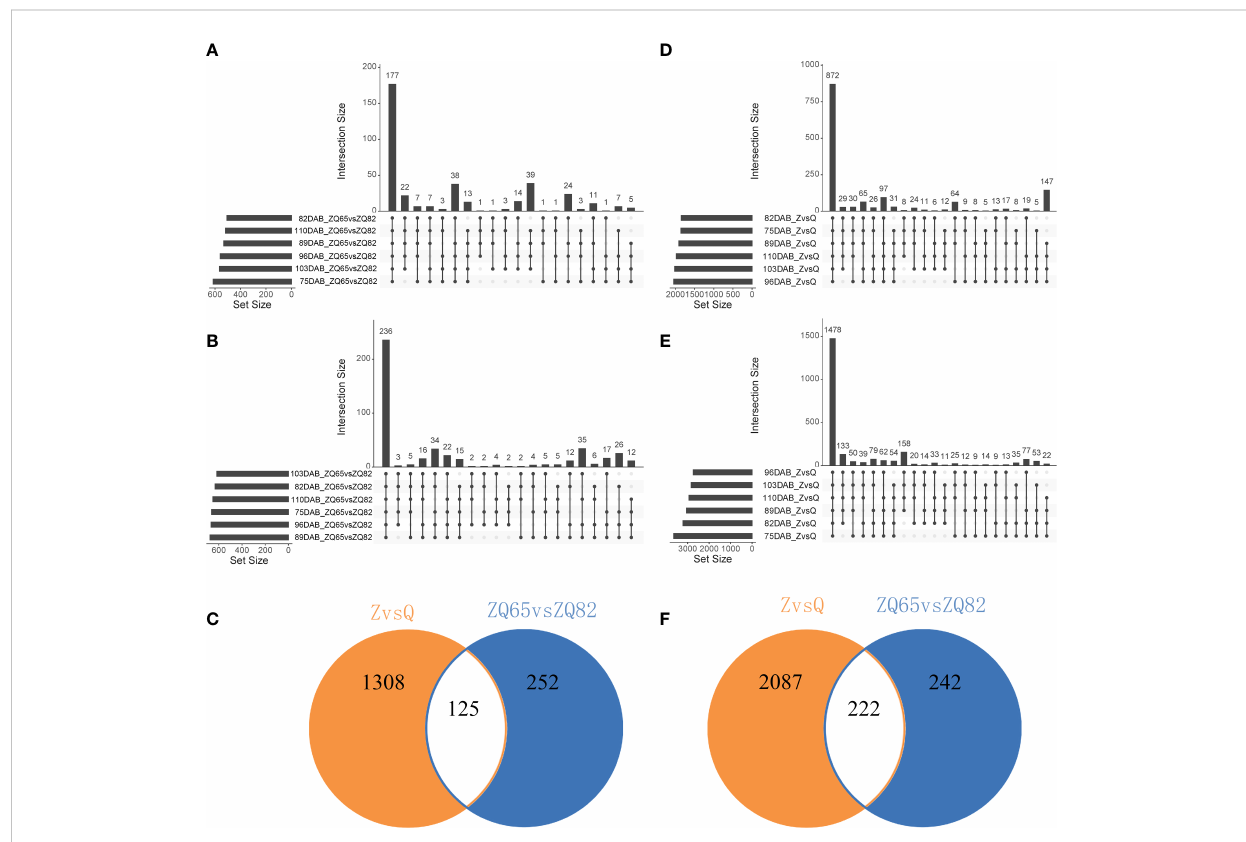
FIGURE 4 The number of DEGs in “ Zaoshengxinshui ” (Z), “ Qiushui ” (Q), “ ZQ65, ” and “ ZQ82 ” at six time points. (A) Upregulated DEGs in “ ZQ65 ” vs. “ ZQ82. ” The upright column represents the number of DEGs at different time points, and the lower dot indicates the time points. The left horizontal column represents the number of DEGs at a single time point. (B) Upregulated DEGs in “ Zaoshengxinshui ” vs. “ Qiushui. ” (C) The intersection of upregulated DEGs in both “ ZQ65 ” vs. “ ZQ82 ” and “ Zaoshengxinshui ” vs. “ Qiushui. ” (D) Downregulated DEGs in “ ZQ65 ” vs. “ ZQ82. ” (E) Downregulated DEGs in “ Zaoshengxinshui ” vs. “ Qiushui. ” (F) The intersection of downregulated DEGs in both “ ZQ65 ” vs. “ ZQ82 ” and “ Zaoshengxinshui ” vs. “ Qiushui. ”